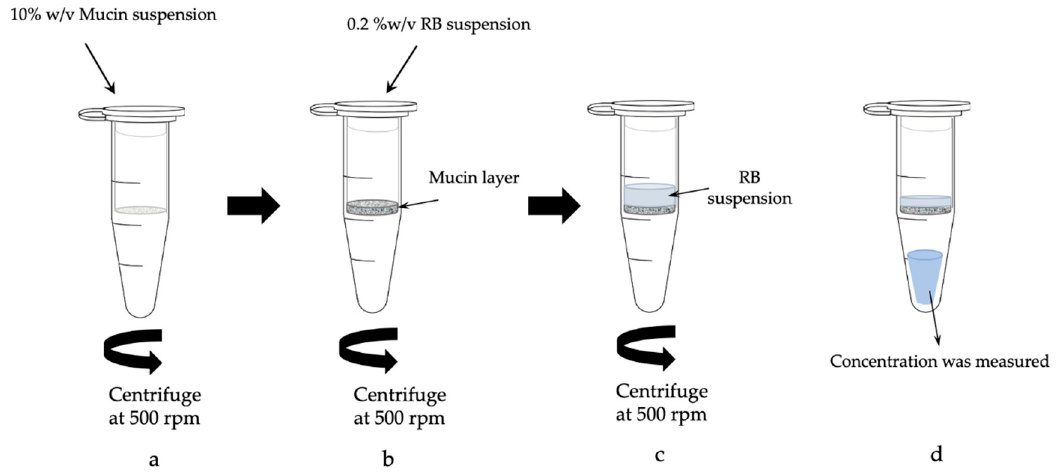
Scheme 1. Method of mucus permeation using centrifugal filtration device with mucin solution.